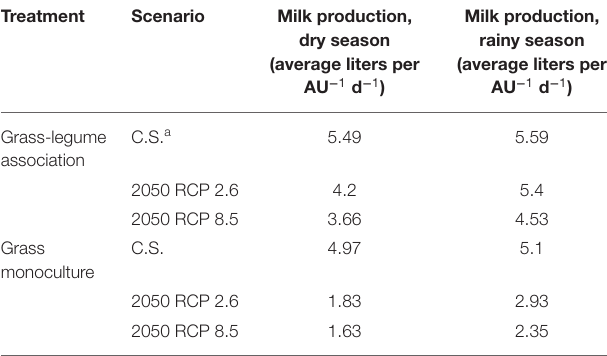
TABLE 6 | Profitability indicators of the simulation model for the grass-legume association and the grass monoculture.